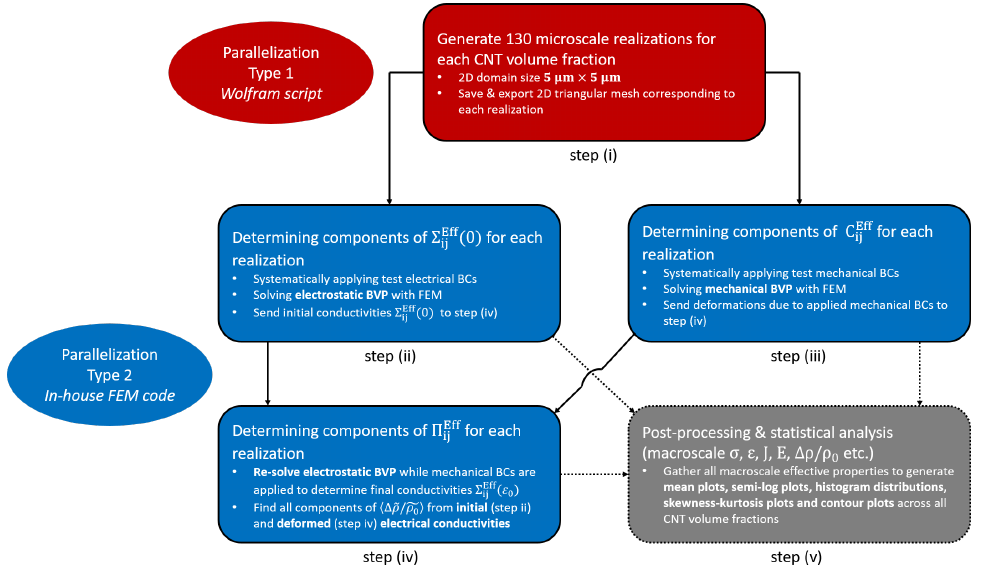
Figure 6. Solution scheme